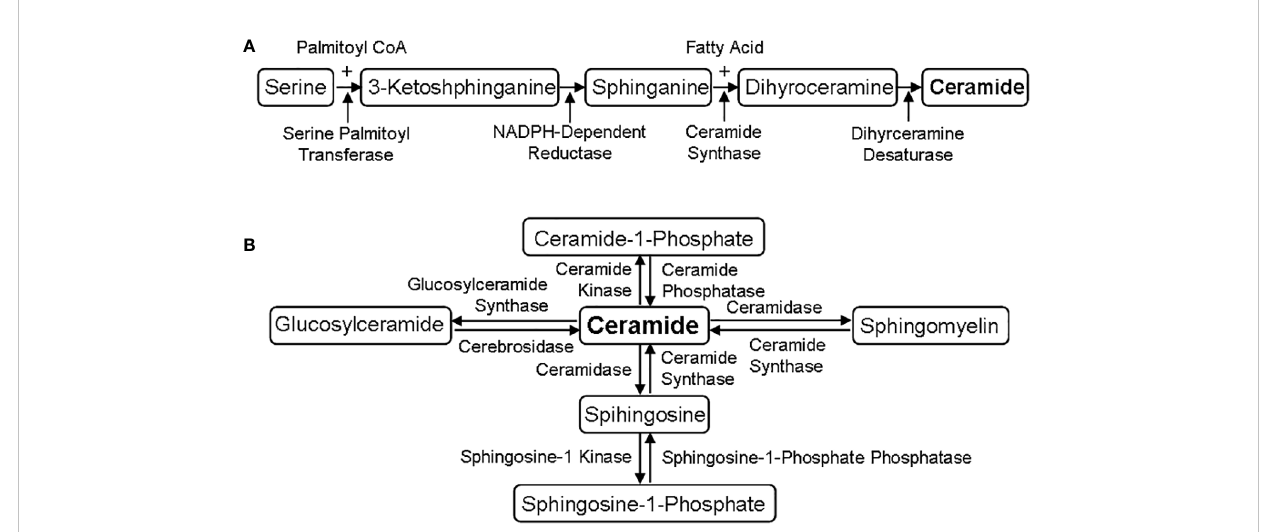
FIGURE 1 Sphingolipid metabolic pathways. (A) De novo synthesis of sphingolipids. The de novo biosynthesis of sphingolipids is from serine and palmitoyl CoA, and fi nally converted into ceramide through four-step reactions under the catalysis of serine palmitoyl transferase, NADPH-dependent reductase, ceramide synthase and dihyrceramine desaturase. (B) Different salvage of sphingolipids. Ceramide is the precursor of all sphingolipids, which can be converted into other phospholipids under the action of speci fi c enzymes, such as ceramide synthase and